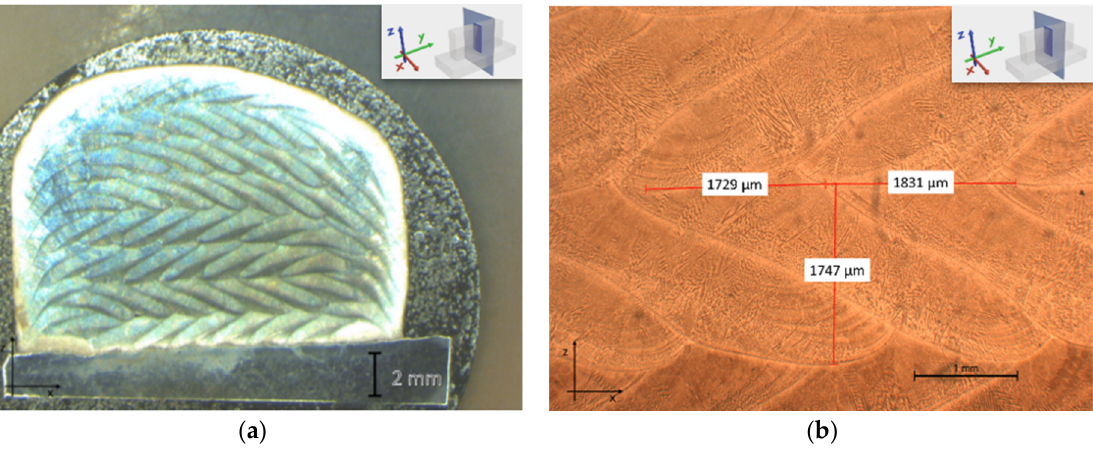
Figure 10. Etched XZ surface cut: ( a ) Sample overview [17]; ( b ) Measured hatch spacing and layer thickness [17].